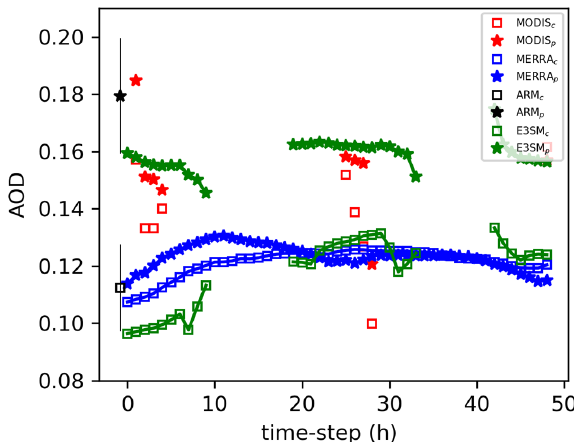
Figure 7. Aerosol optical depth averaged along forward trajecto- ries in MERRA-2, E3SM, MODIS, and ARM observations for tra- jectories with below-median (square) and above-median (star) ini- tial CCN concentrations of 110 for MODIS, ARM, MERRA-2, and E3SM data sets. Table 3. Fractional change in cloud condensation nuclei (CCN) concentration at 0.2% supersaturation based on trajectories sorted by above- and below-median precipitation rate (with a threshold of 0.05mmh − 1 ) for the IMERG and E3SM simulation experiments listed in Table 2. Precipitation is aggregated in both the Eulerian (EUL) and Lagrangian (LAG) frames of